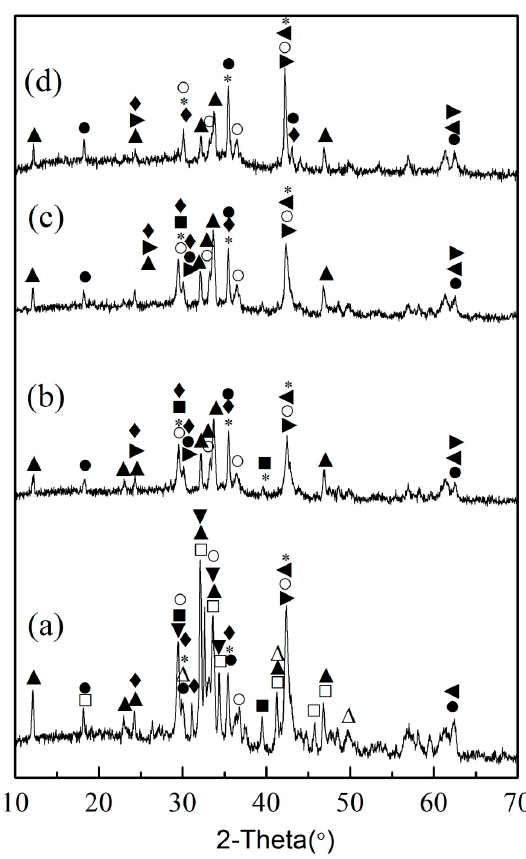
Figure 2. Representative XRD pattern of slag under different process (Cu K α ) ( ▲ CaFA; ○ Ca 3 Fe 2 (SiO 4 ) 3 ; * CaFe(SiO 3 ) 2 ; (cid:7) CaMgSi 2 O 6 ; RO; (cid:4) CaCO 3 ; (cid:52) CS; (cid:3) C 2 S; (cid:72) C 3 S; (cid:73) SiO 2 ; (cid:74) (cid:35)